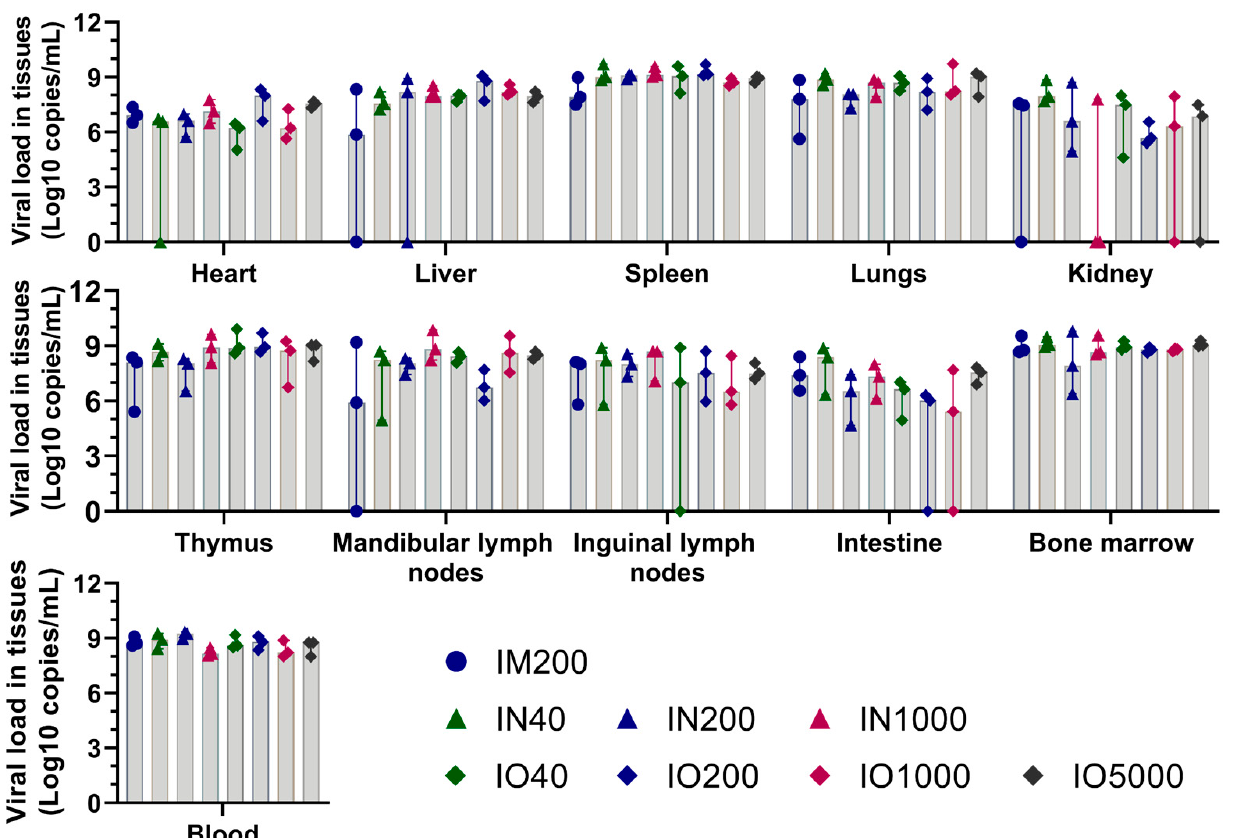
Figure 3. Viral load in tissues and blood. ASFV viral load in tissues (heart, liver, spleen, lungs, kidneys, thymus, mandibular lymph nodes, inguinal lymph nodes, intestines, bone marrow) and blood from pigs in the IM group (IM200), IN group (IN40, IN200, IN1000), and IO groups (IO40, IO200, IO1000 and IO5000).